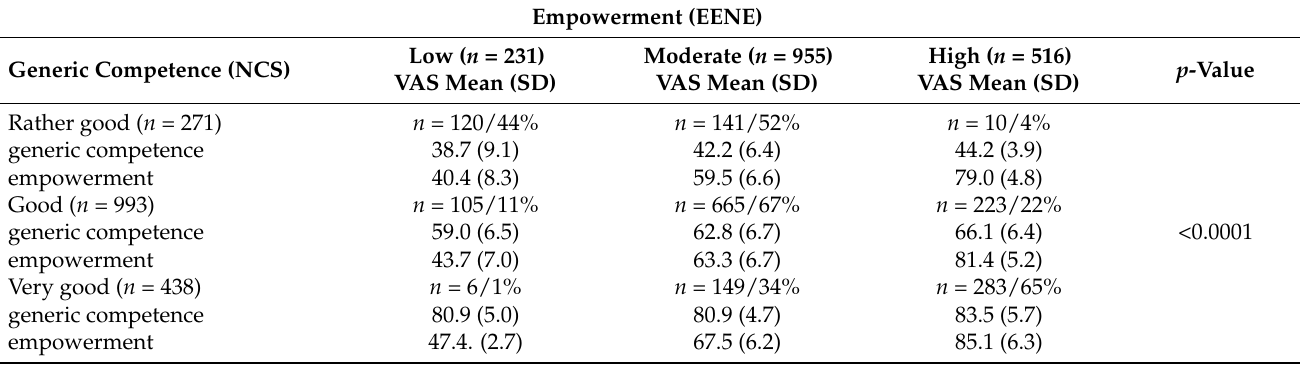
Table 5. The association between empowerment and competence in different groups, analyzed with Fisher’s exact test ( n =